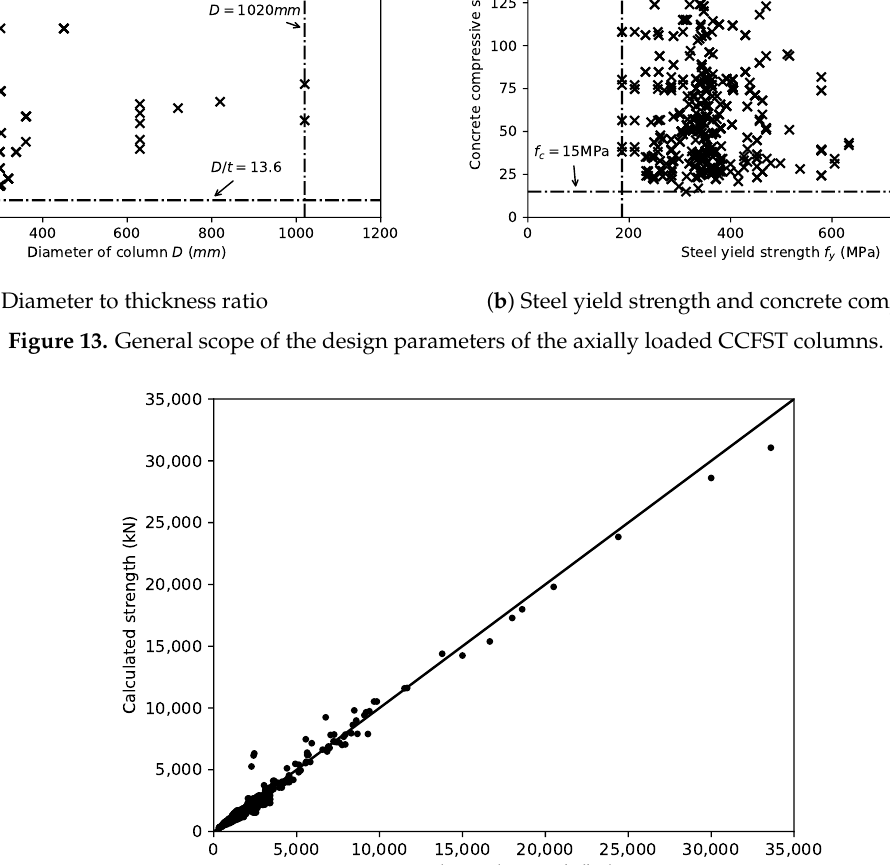
Figure 14. Calculated axial bearing capacity versus the experimental results.